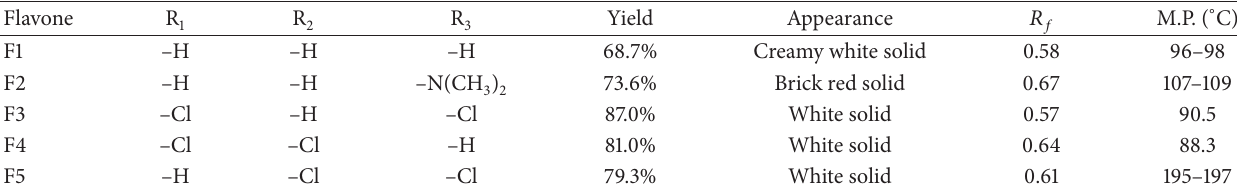
Table 1: Physical parameters of flavone derivatives.